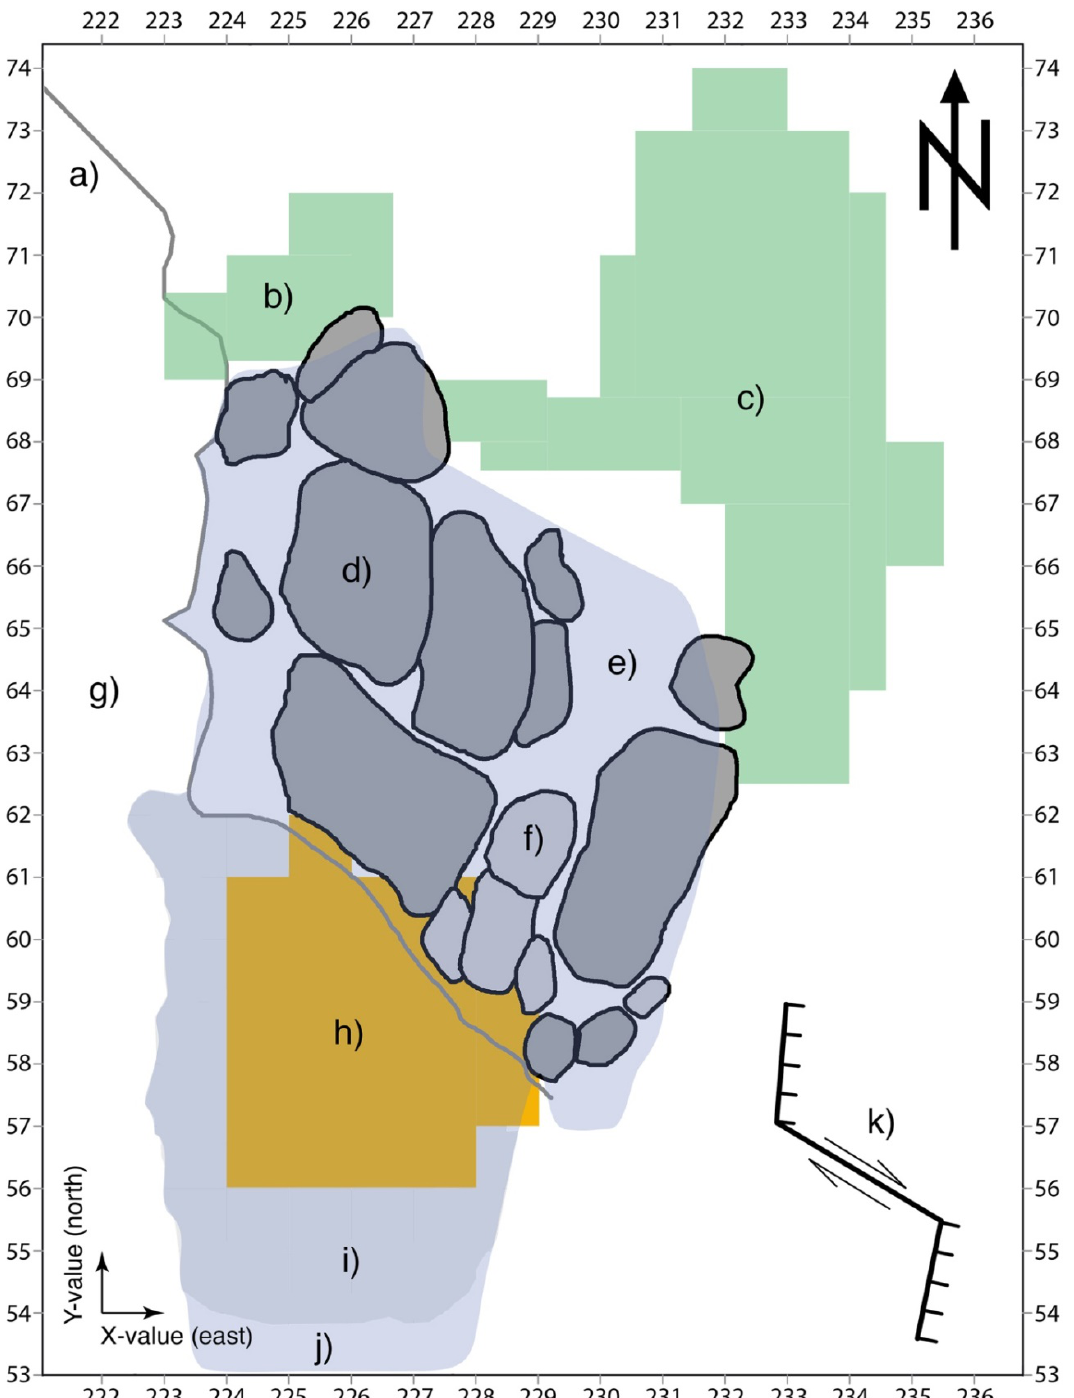
Figure 6. Schematic map of VP II showing: a) The cliff face ( falaise ), extending in the north-western direction toward VP I; b) Test pit (2014, 2015) to evaluate the extent of stratified sediments in the northern direction, removal ( décapage ) of mixed sediments; c) Test pit (2015) to evaluate the extent of stratified sediments and determine the slope of the bedrock, removal ( décapage ) of mixed sediments; d) Collapsed limestone blocks that once formed the rock-shelter and remain where they fell (dark grey); e) Area where sediments of GH 1 and 2 are almost completely removed (roughly equivalent to the potential area of stratified sediments); f) Original position of collapsed roof-blocks that have been removed (light grey); g) Plateau of the Montadiot massif; h) Position of the current excavation (2010-2015) of GH 3, GH 4x and GH 4 at the entrance of the cave tunnel; i) Measured extent of the cave tunnel; j) Presumed extent of the cave tunnel and of stratified sediments and k) Illustration of geomorphological fracture directions. (Basal GIS map from Ch. Hoyer, redrawn and completed by J. A. Frick and S. P.